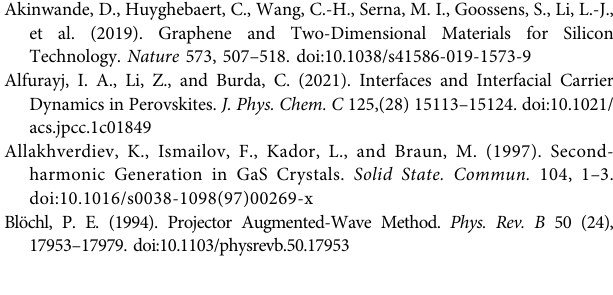
Frontiers in Materials |